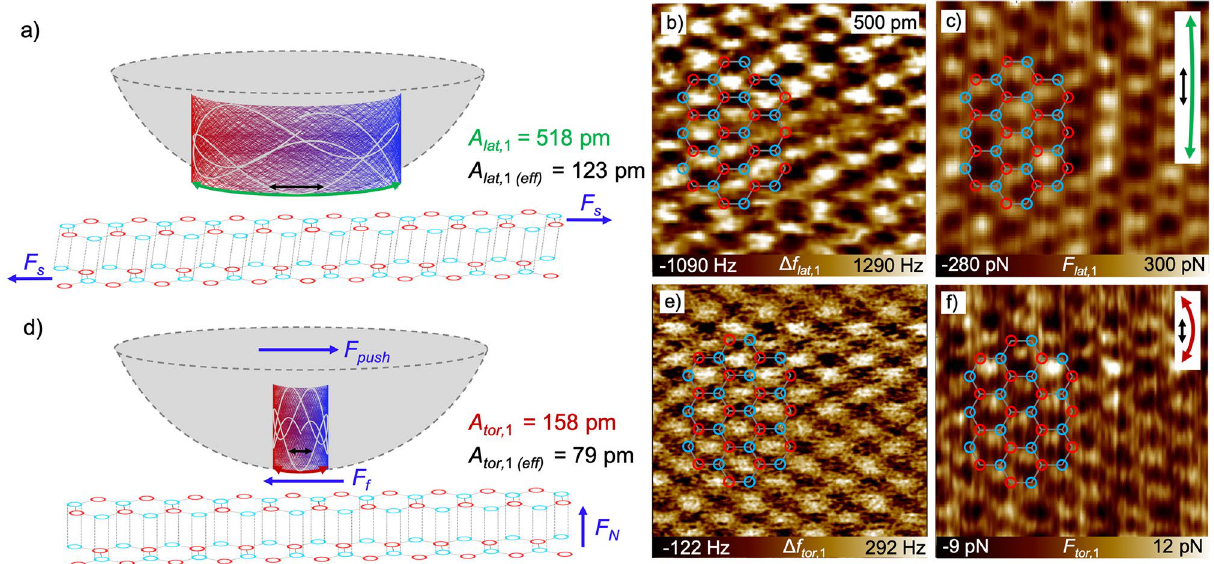
Figure 5. Scheme of the interaction between tip and HOPG surface for ( a ) a shearing interaction resulting from imaging in the AMFlex2-FMLat1-FMFlex3 mode with A lat, 1 = 518 pm ( F s : shear force) and ( d ) a frictional interaction resulting from imaging in the AMFlex2-FMTor1-FMFlex3 mode with A tor, 1 = 158 pm, where F N is the normal force acting perpendicular to the surface, F push is the force originating from the movement of the tip in the direction of the in-plane oscillation and F f is the frictional force counteracting F push ( A flex, 2 = 110 pm and A flex, 3 = 145 pm). ( b, e ) lateral and torsional frequency-shift images. ( c , f ) corresponding lateral and torsional force images calculated by the Fourier method and using the effective lateral/torsional amplitudes A lat, 1 (eff) = 123 pm and A tor, 1 (eff) = 79